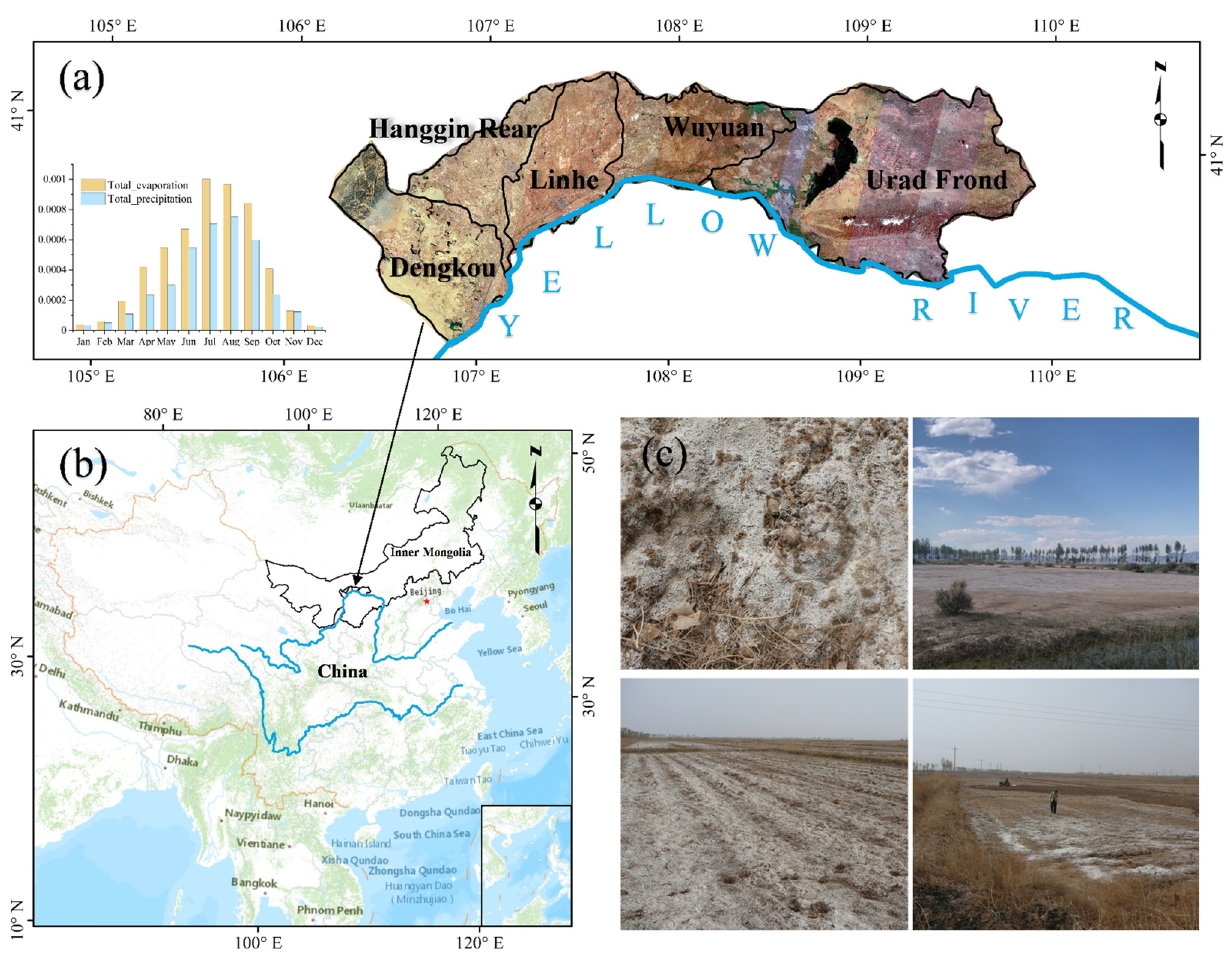
Figure 1. ( a ) Location of HID with histogram diagram of total evaporation and total precipita- tion in the last decade (meteorological data were obtained from ERA5_LAND data collection) and PlanetScope images acquired from 1 to 13 April in 2021 (shown in false color composited-R: NIR (Near-Infrared) band, G: Green band, B: Blue band). ( b ) The location of HID in China and the Inner Mongolia Autonomous Region. ( c ) Field photographs taken on April 2021, showing the salt on the soil surface before crops were